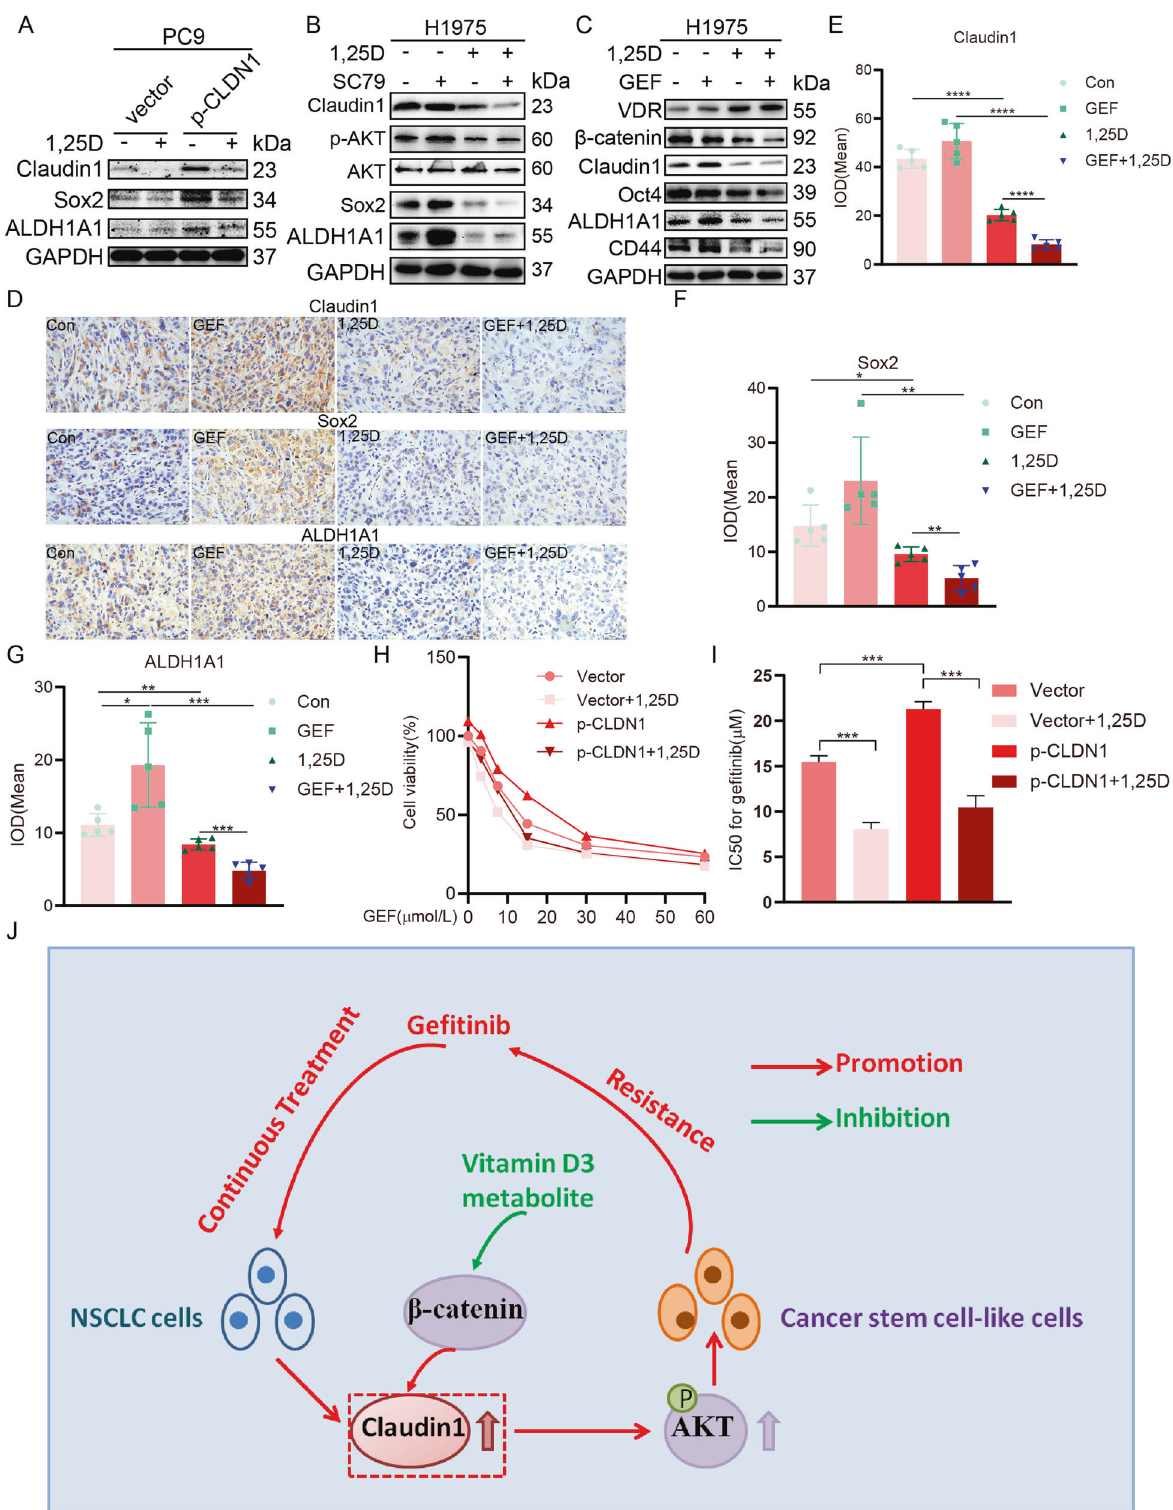
GAPDH mRNA expression levels were used for data normalization. The mRNA primer sequences (GenScript, Nanjing, China) used for